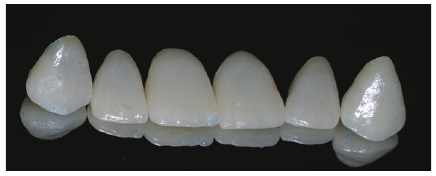
Figure 14: Lithium disilicate veneers.